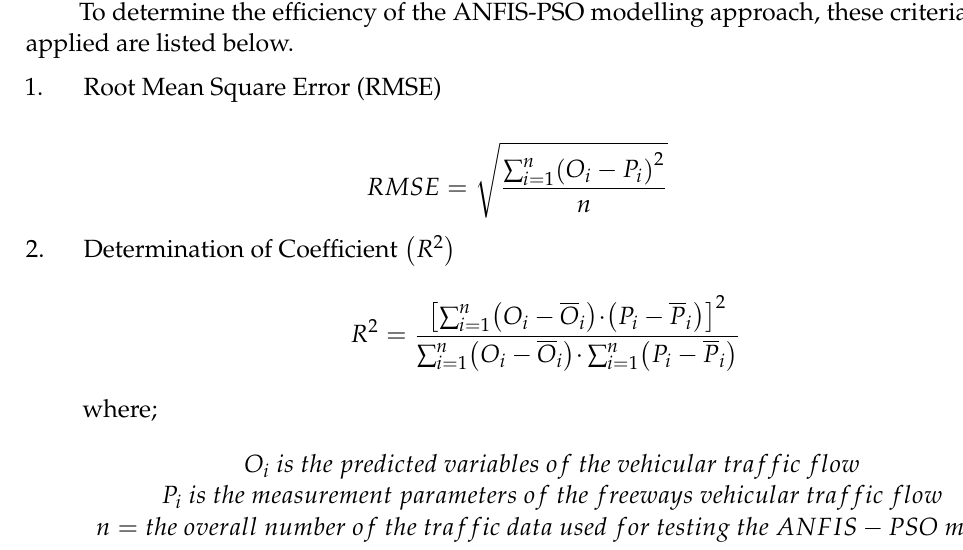
Figure 6. Stages of the ANFIS-PSO training and testing Performance Evaluation of ANFIS-PSO Model